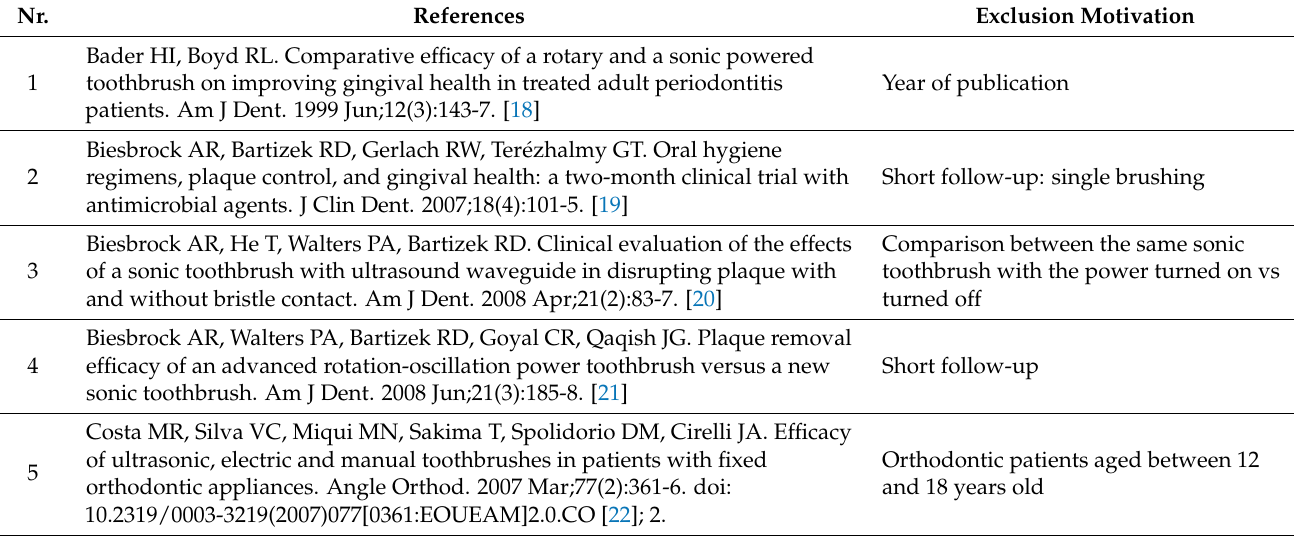
Figure 1. Articles inclusion. Flow chart diagram (2009) of search strategy adapted from PRISMA. Table 1. Excluded articles after full-text screening.